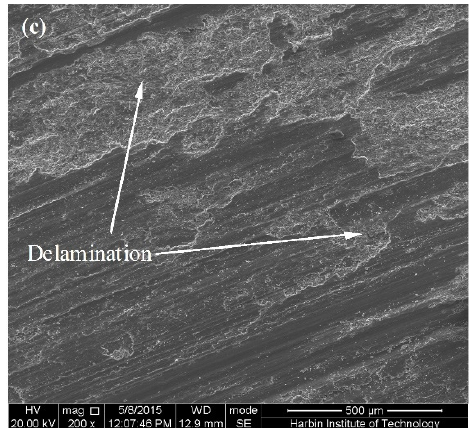
Figure 12. Worn surface morphology of the rheoformed composite parts at different sliding velocities: ( a ) 0.8 m/s, ( b ) 1.2 m/s and ( c ) 1.6 m/s.